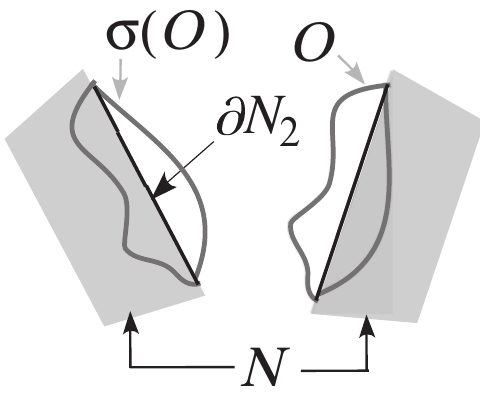
Figure 1. The white area is U